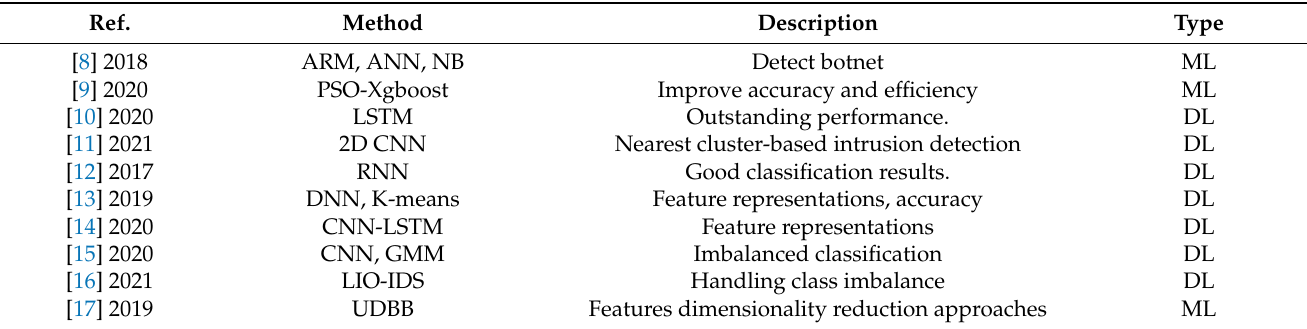
Table 1. Summary of some related methods. Ref.